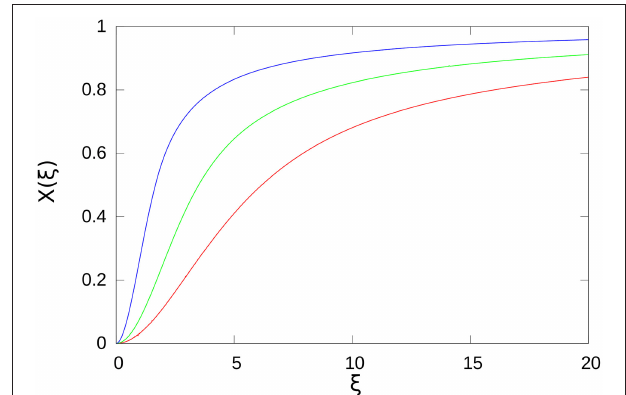
FIGURE 2 | Adimensional ratio functions X ( ξ ) for the three distributions, plotted with the same colors as in Figure 1 .